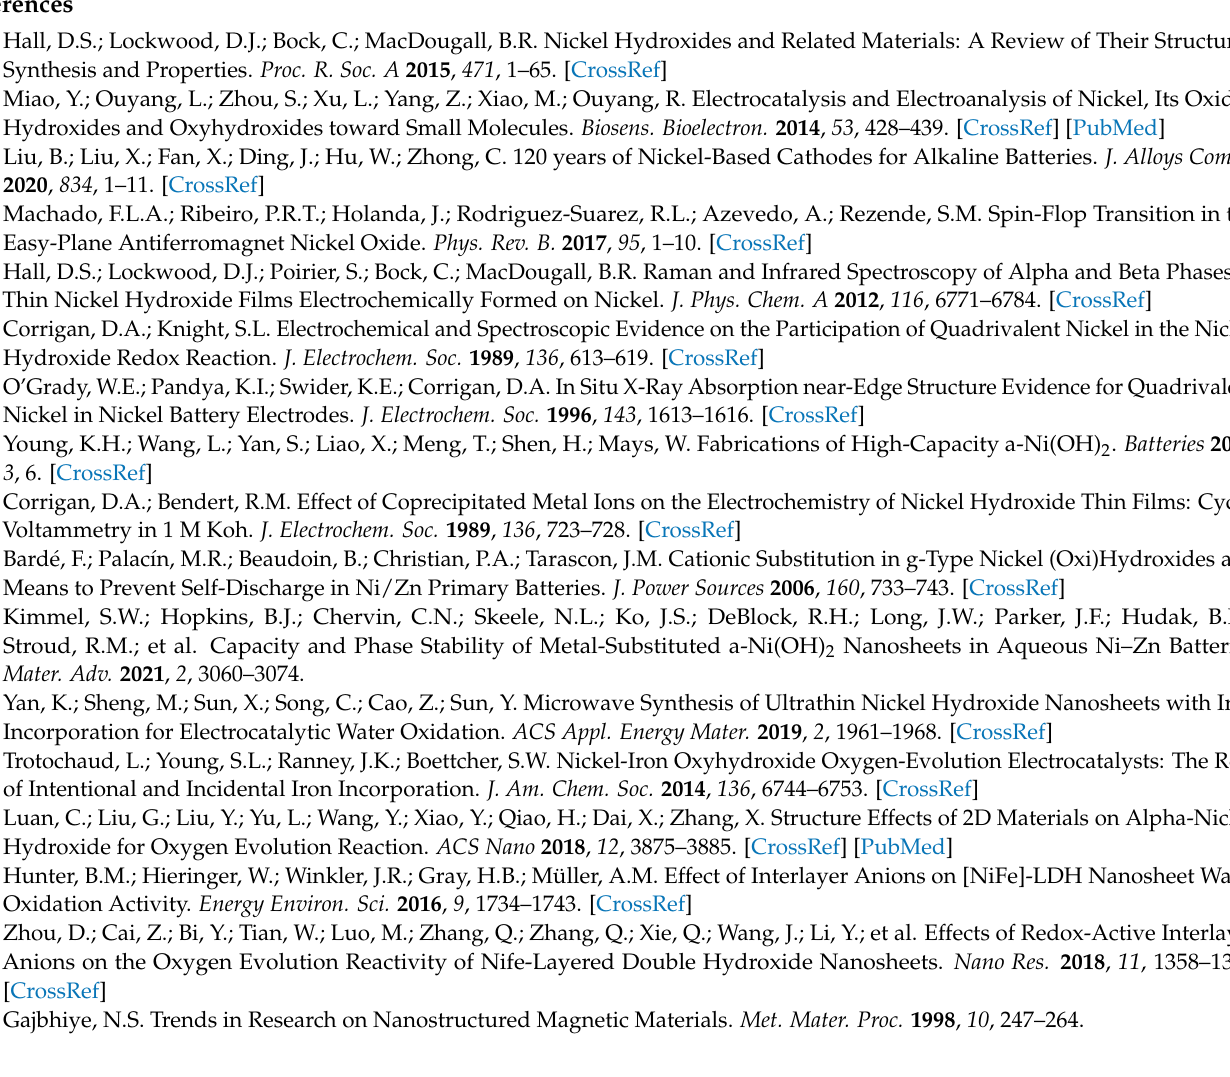
magnetic fields. Figure S8: (a) FC and ZFC Magnetization, (b) M-H loop at 2 K, and (c)M-H loops at 4 K, 8 K, 10 K for 50% Fe (Ni 0.50 Fe 0.50